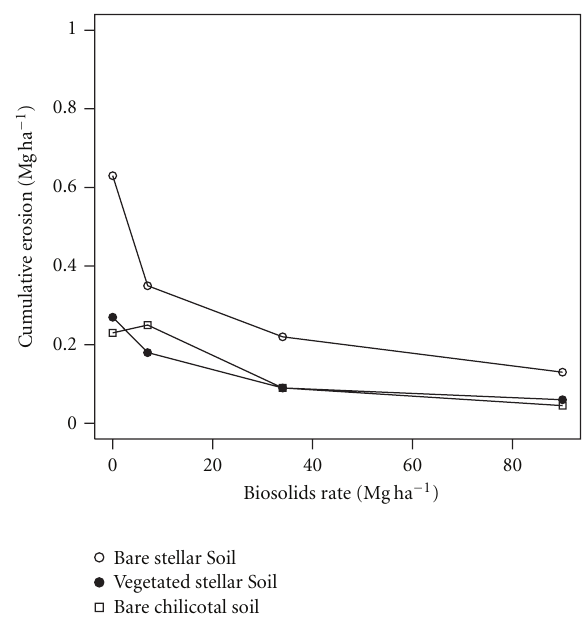
Figure 15: Cumulative erosion (Mgha − 1 ) during a 30-min simu- lated rainfall (79mm) from three soil cover conditions as a ff ected by biosolids application (redrawn from [17]).